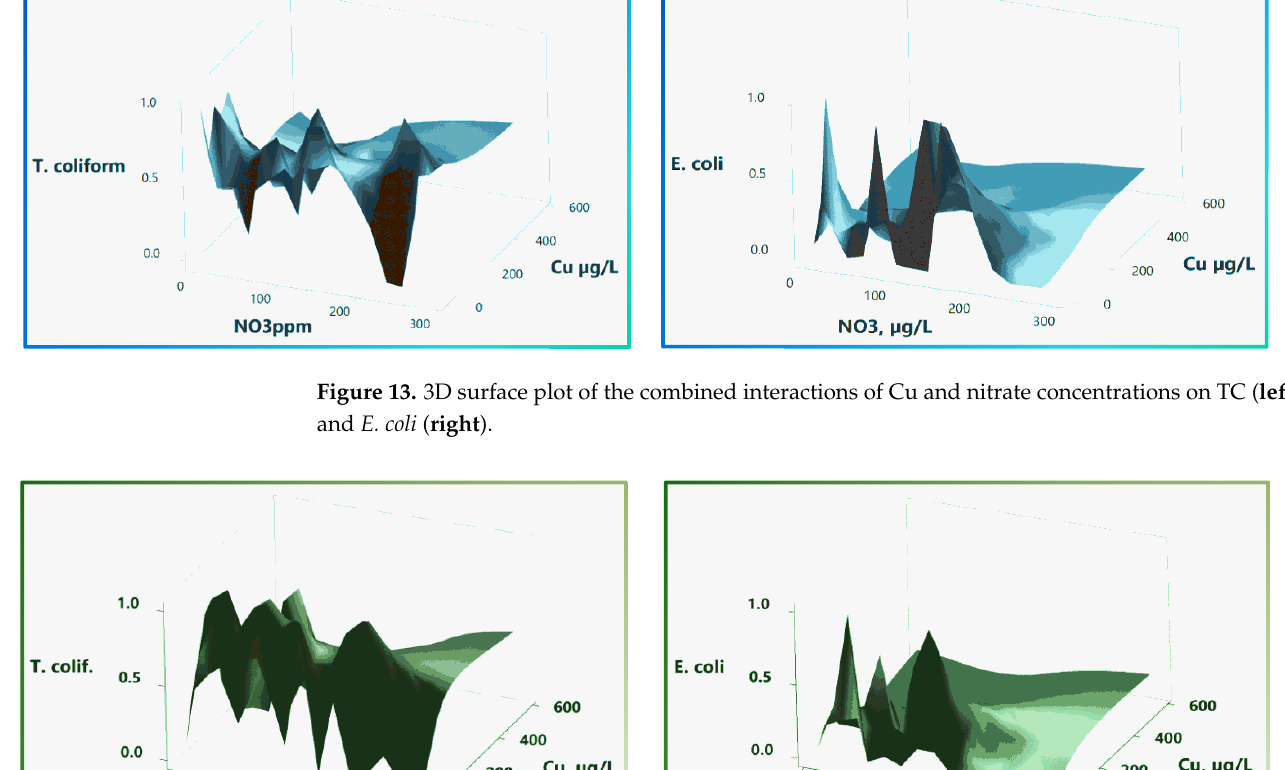
Figure 13. 3D surface plot of the combined interactions of Cu and nitrate concentrations on TC ( left ) and E. coli ( right ).